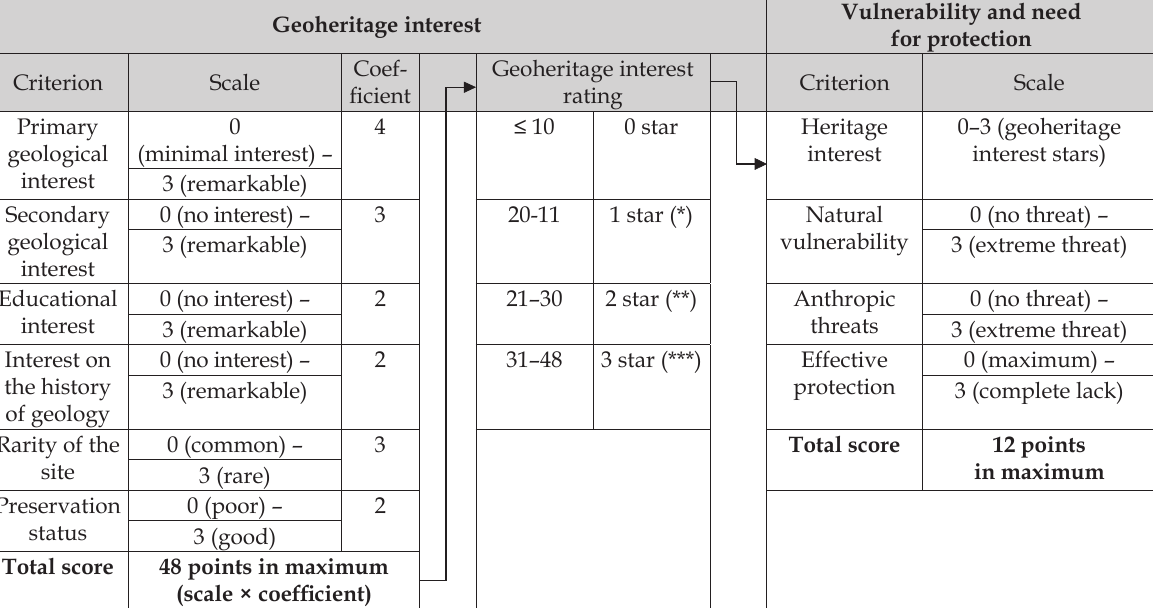
Table 1. Synthesis of the national geosite inventorying method of France, the INPG, based on de Wever et al.